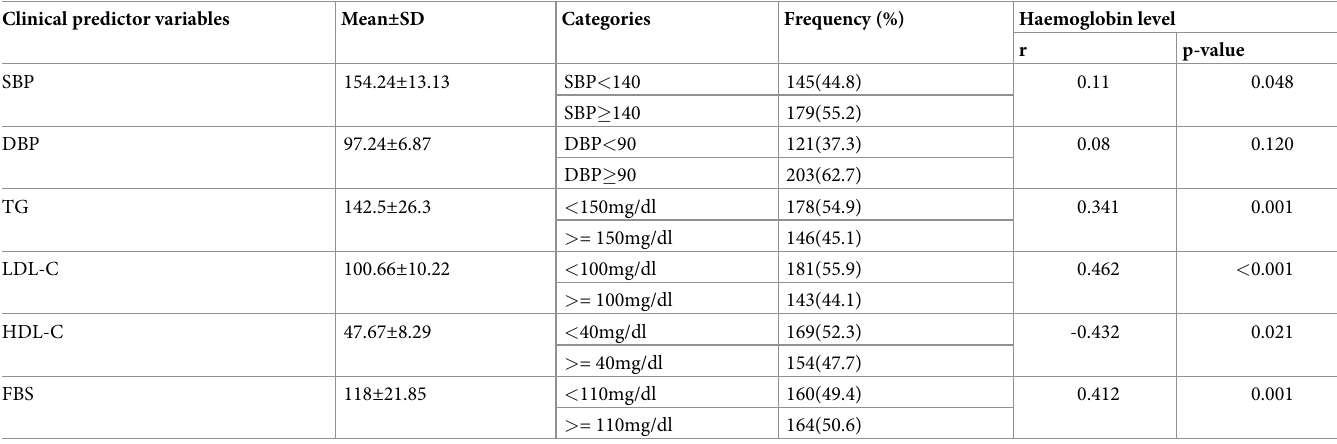
Table 2. Correlation analysis of hemoglobin and clinical factors. Clinical predictor